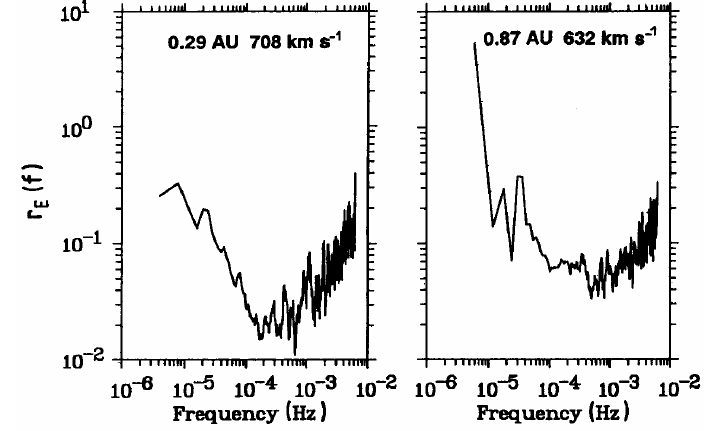
Figure 44: Ratio of e – over e + within fast wind at 0.3 and 0.9 AU in the left and right panels, respectively. Image reproduced by permission from Marsch and Tu (1990a), copyright by